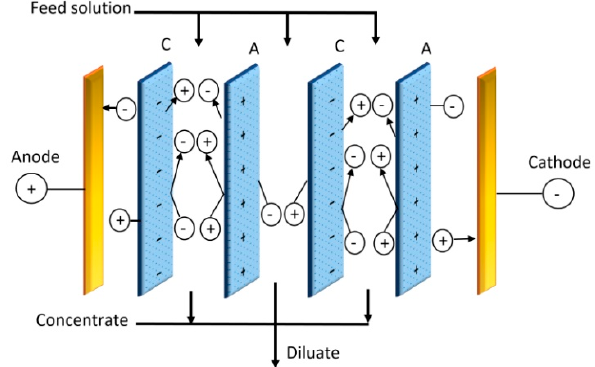
Figure 7. Schematic diagram of the electrodialysis (ED) process.